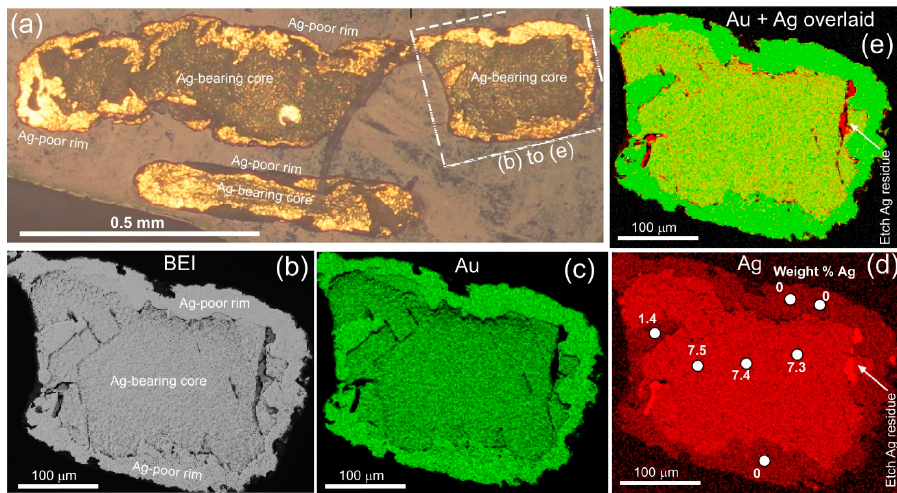
Figure 6. Detailed view of a moderately flattened gold particle from the August 2017 sample from the Waikaia placer mine. ( a ) Incident light view of whole particle, with an adjacent smaller and more flattened particle; ( b – e ) Backscatter electron image and Au, Ag maps of the portion of the particle indicated in ( a ). Point Ag analyses are shown in ( d ). Small bright red Ag-rich patches in ( d , e ) are artefacts of the acid etching